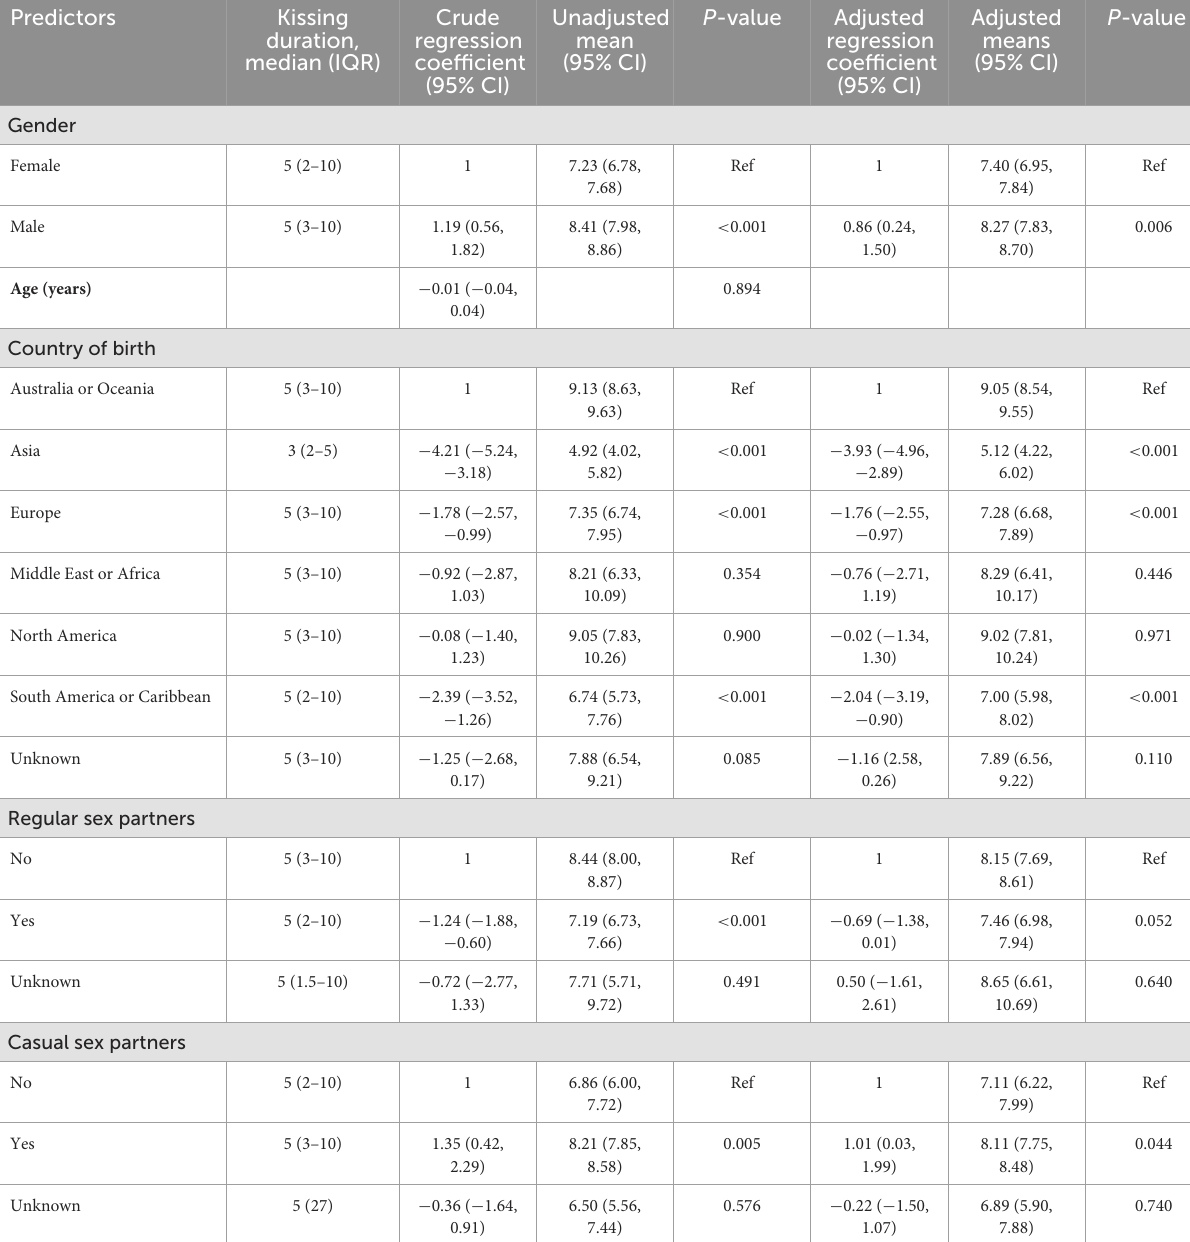
TABLE 3 Univariable and multivariable linear regression analyses of the association between demographic factors and the duration of kissing while on top of partner among 2,291 heterosexual men and women who had opposite-gender kissing partners in the past 3 months. Predictors Kissing